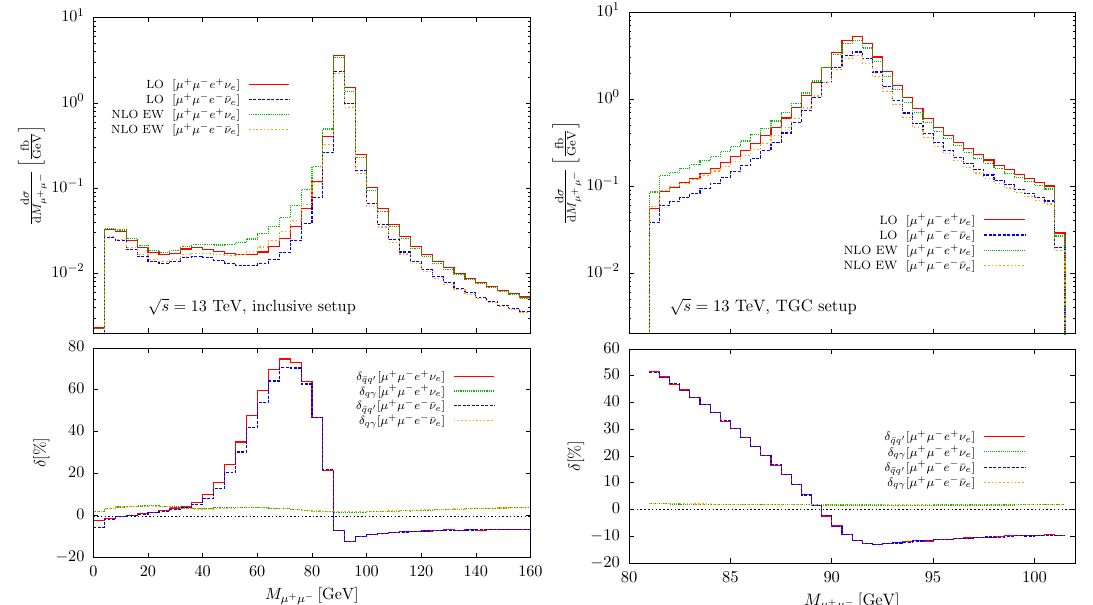
Figure 2 . Distribution in the invariant mass of the µ + µ − pair in the inclusive setup (left panel) and in the TGC setup (right